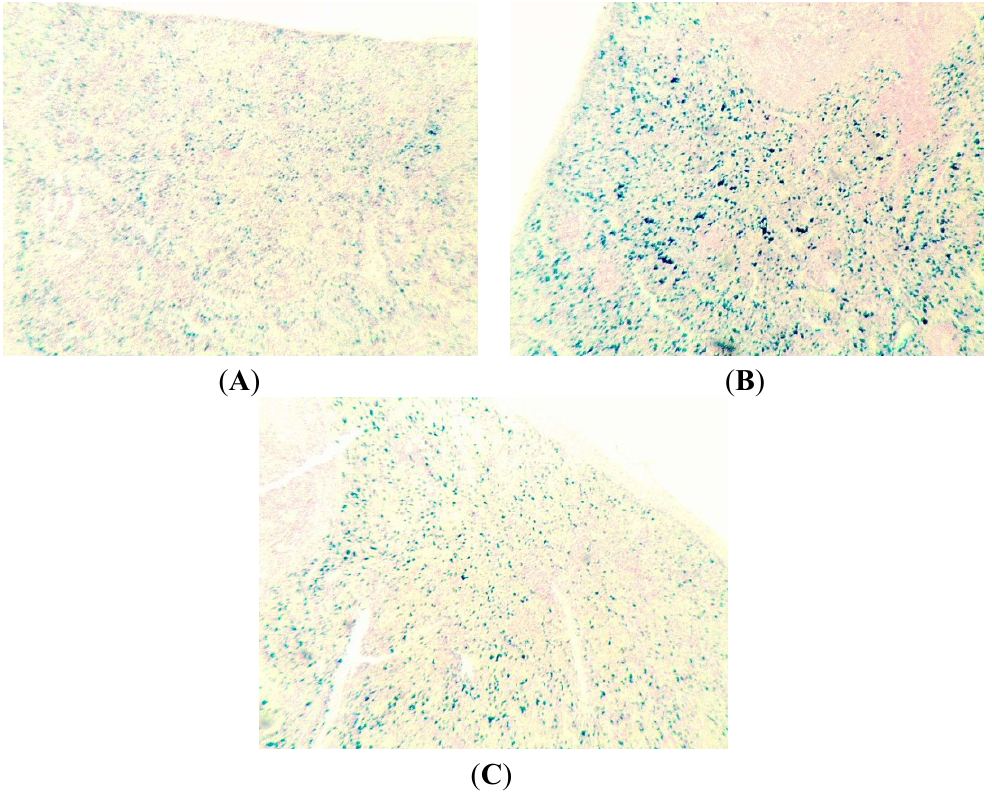
Figure 6. Hemosiderin distribution the spleen’s red pulp of rats exposed ( A ) to water (Control); ( B ) to water suspension of copper oxide nanoparticles; and ( C ) to the same against the background of BPC administrations. Perl’s stain; magnification